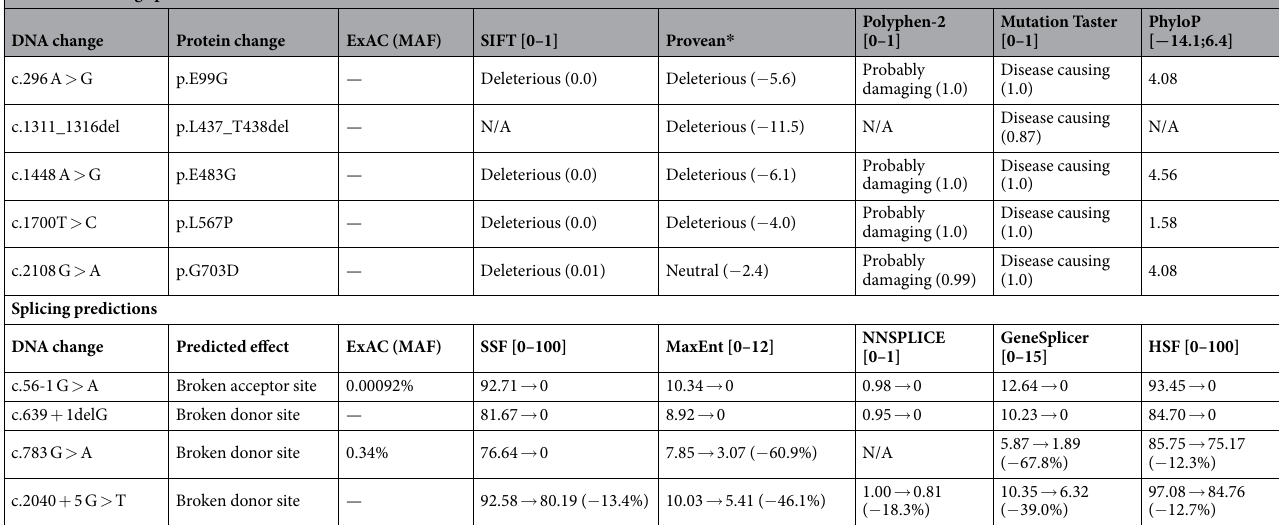
Table 1. Pathogenicity predictions for missense and splice site mutations based on in silico analyses. ExAC, Exome Aggregation Consortium; MAF, minor allele frequency. * A score threshold of − 2.5 was used. N/A, not